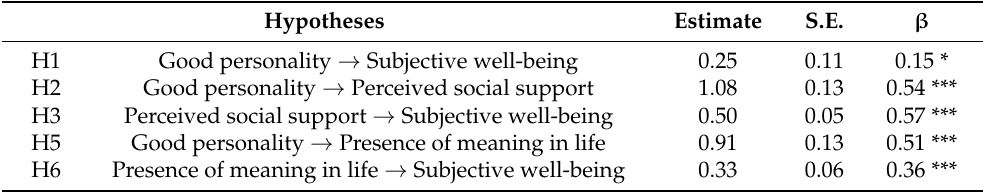
Table 4. SEM Results for Model 1.